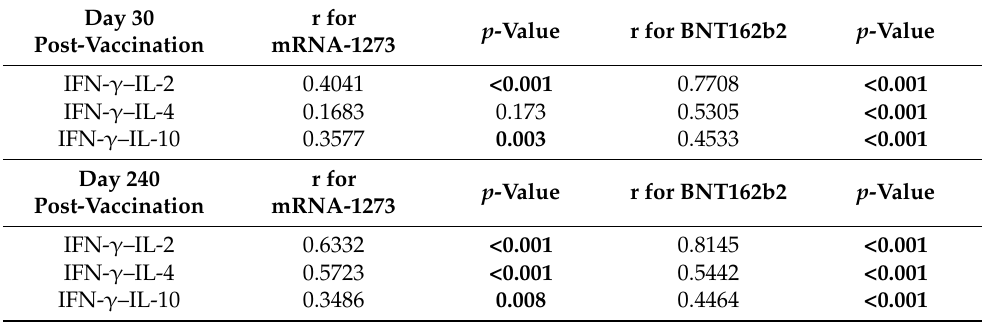
Table 6. Correlation between cellular responses on days 30 and